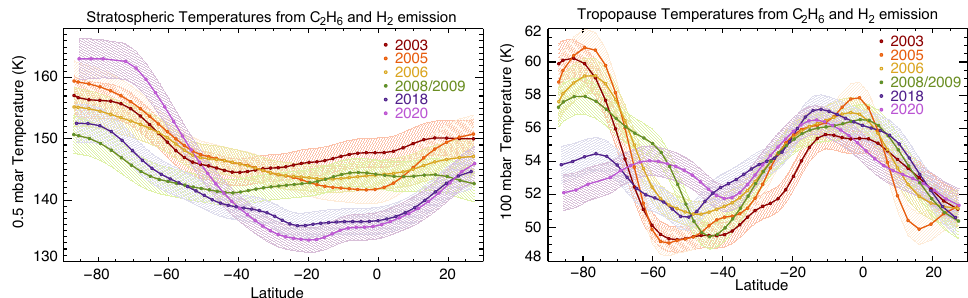
Figure 20. Neptune’s temperatures versus planetocentric latitude from ground-based images dating from different years, adapted from Roman et al. [74]. Shaded envelopes indicate uncertainties. Temperatures are shown at 0.5 mbar ( left ) and 100 mbar ( right ), corresponding to peaks in the contribution from stratospheric ethane (12.2 µ m) and tropospheric hydrogen CIA ( ∼ 18–25 µ m). The stratospheric temperatures vary in time, with brightening at the pole in recent years. Tropospheric temperatures are largely invariant, except for the south pole. Data are from Keck-LWS (2003), Gemini-N-Michelle (2005), VLT-VISIR (2006–2018), and Subaru-COMICS